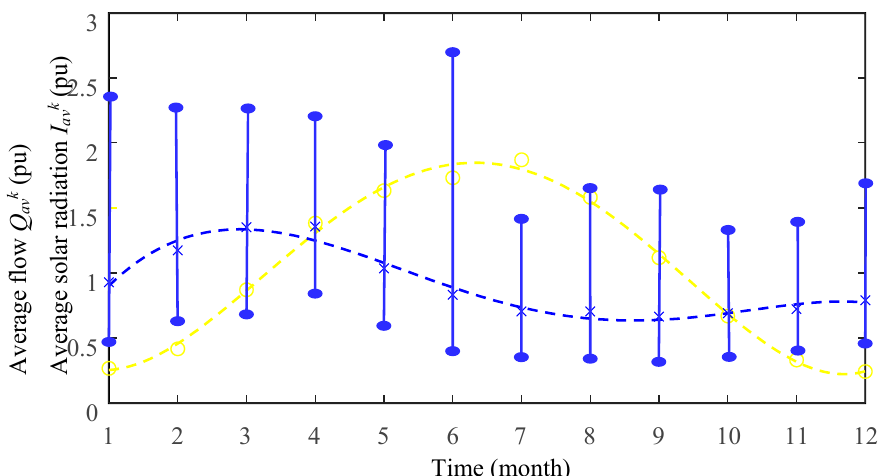
Figure 13. Average monthly solar radiation (yellow) and river flow (minimum, average and maximum—blue) in Poland. The power of the run-of-the-river hydropower plant was calculated based on the flow profile presented in Figure 13 using the model presented in Section 2.2. The necessary condition of the hybrid system control was that the sum of PV and hydro energy E hs (av- eraged within the month) covered the load demand. The two-dimensional set (with hydro and PV sizes as coordinates) of annual surplus energy E hs related to the average load en- ergy E l is presented in Figure 14.